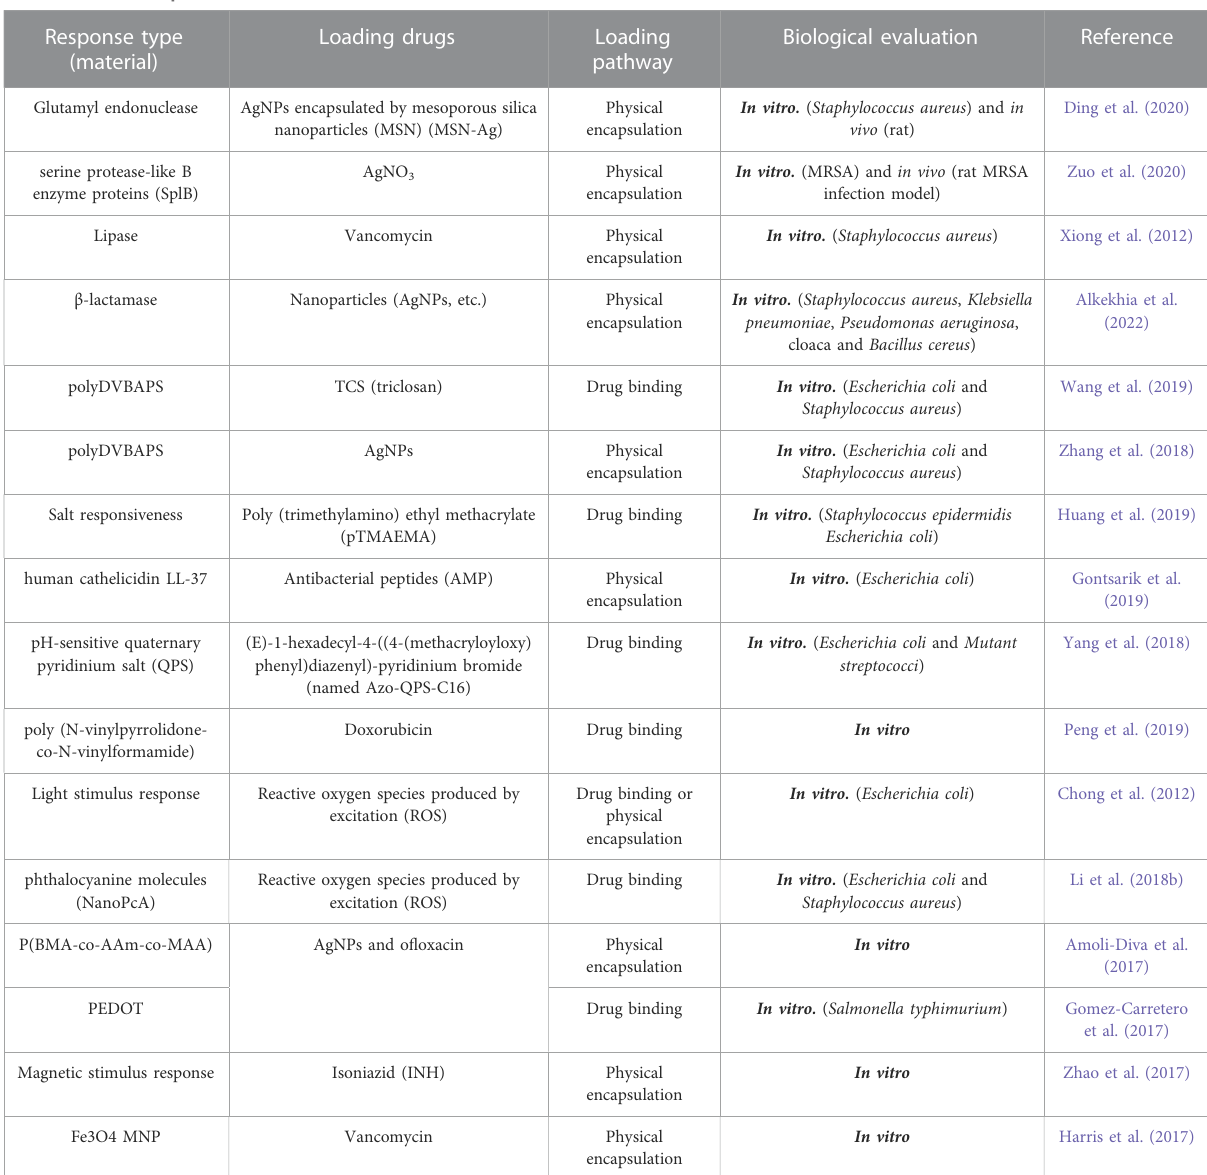
TABLE 1 Stimulus response